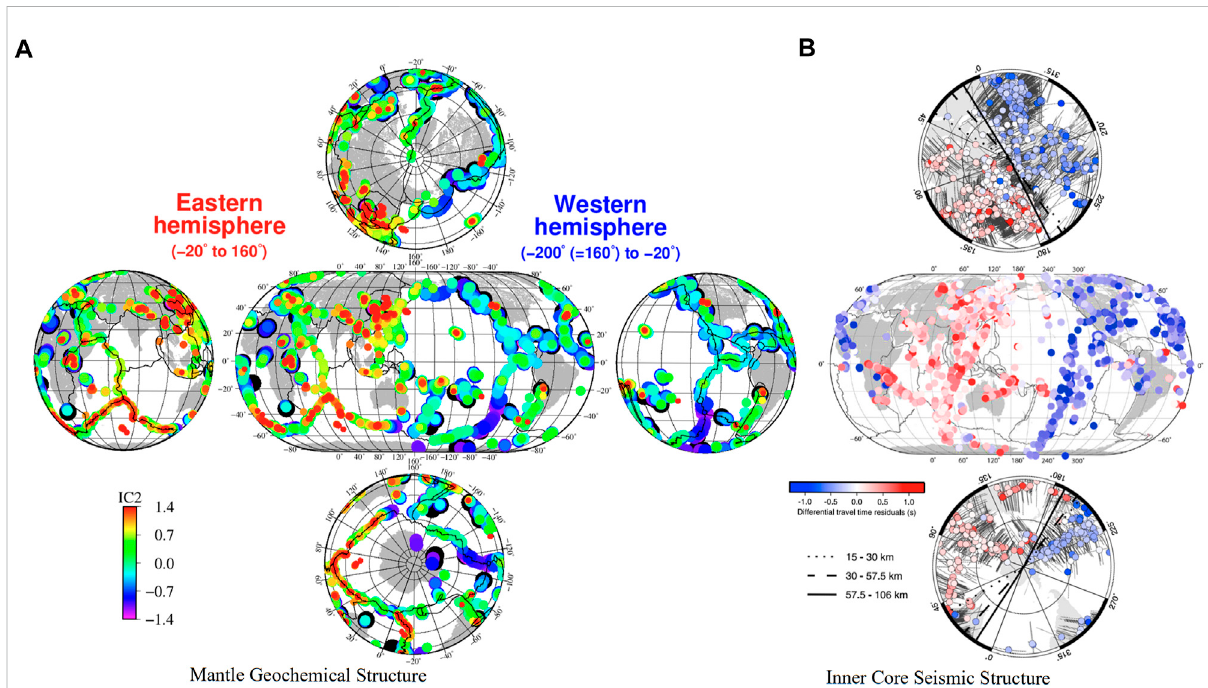
FIGURE 4 Geographical distribution of (A) a hydrophile component (IC2) extracted by independent component analysis (ICA), and (B) the relative seismic velocitynearthesurfaceoftheinnercore(afterWaszeketal.,2011).In (A) ,thevariabilityisshownbythesizeofthecolor-codedsymbols(smallerfor the higher IC2 value, corresponding to a greater amount of hydrophile component). In (B) , the color coding represents differential travel time residuals,rangingfrom − 1.3 s(darkblue)to+1.3 s(darkred).Thecentrallongitudeofthismapis160 ° E.AsinFigure2B,thelongitudeofthesharp hemisphere boundary varies with increasing depth below the inner core boundary (ICB). In the two maps of polar regions, the solid line represents the boundary at 57.5 – 106 km below ICB, the broken line at 30 – 57.5 km below ICB, and the dotted line at 15 – 30 km below ICB (Figure 5 of Waszek and Deuss,